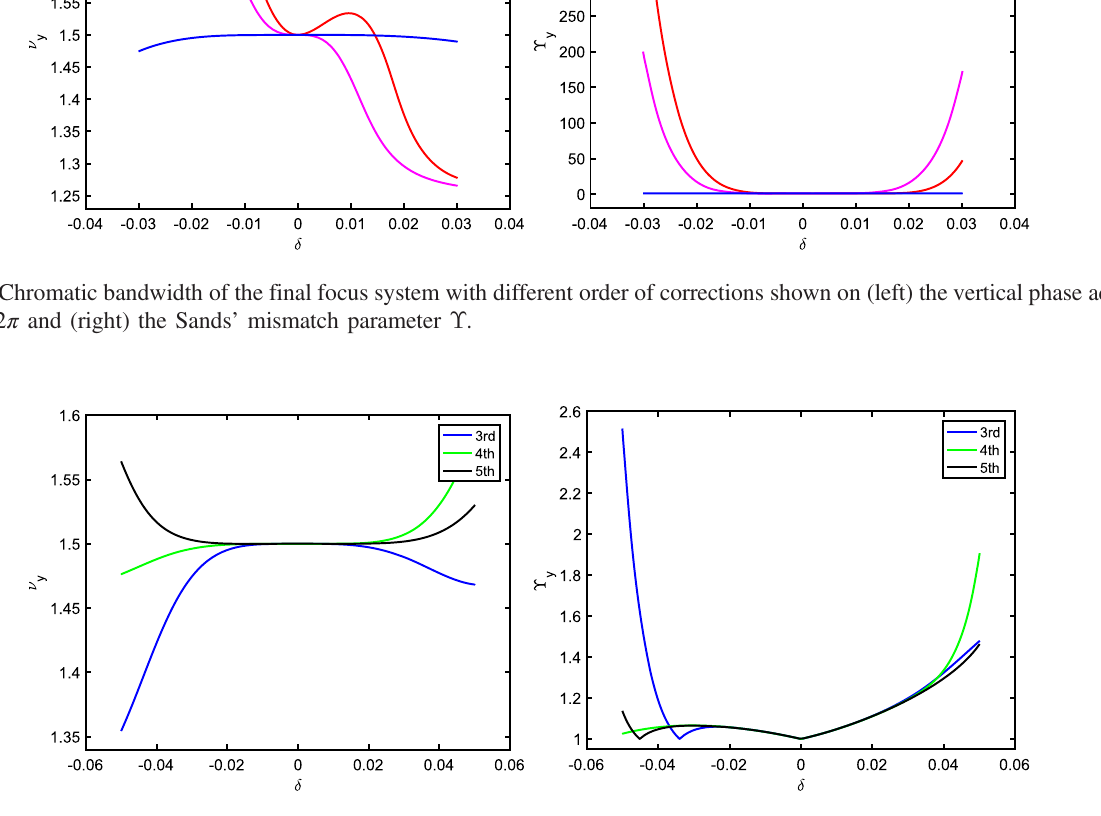
FIG. 11. Improved chromatic bandwidth of the final focus system with higher order of corrections shown on (left) the vertical phase advance in unit of 2 π and (right) the Sands ’ mismatch parameter ϒ